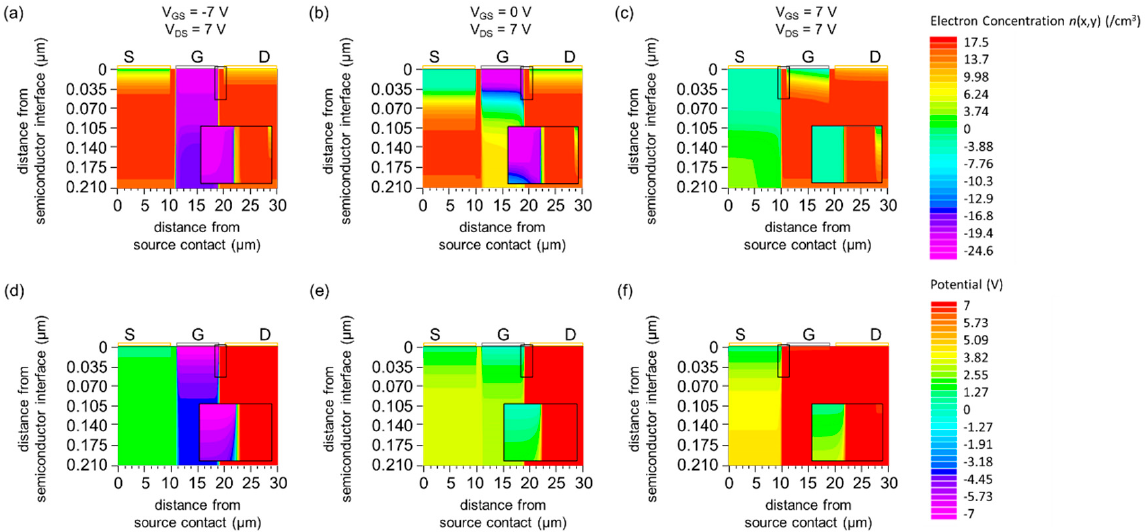
Figure 4. ( a – c ) Simulated carrier concentration distribution for n ( x , y ) ( a ) V GS = − 7 V and V DS = 7 V ( I G -dominant regime), ( b ) V GS = 0 V and V DS = 7 V (off regime), ( c ) V GS = 7 V and V DS = 7 V (normal- operation regime). ( d – f ) Simulated potential distribution V ( x , y ) for ( d ) V GS = − 7 V and V DS = 7 V, ( e ) V GS = 0 V and V DS = 7 V, ( f ) V GS = 7 V and V DS = 7 V. The entire semiconductor layer is shown for all panels ( a – f ). A magnified view of the semiconductor region near the gate electrode (18 µm ≤ x ≤ 20 µm for (a,b,d,e) and 9 µm ≤ x ≤ 11 µm for ( c , f )) is shown for all panels. The work function of the gate is W G = 5.4 eV.